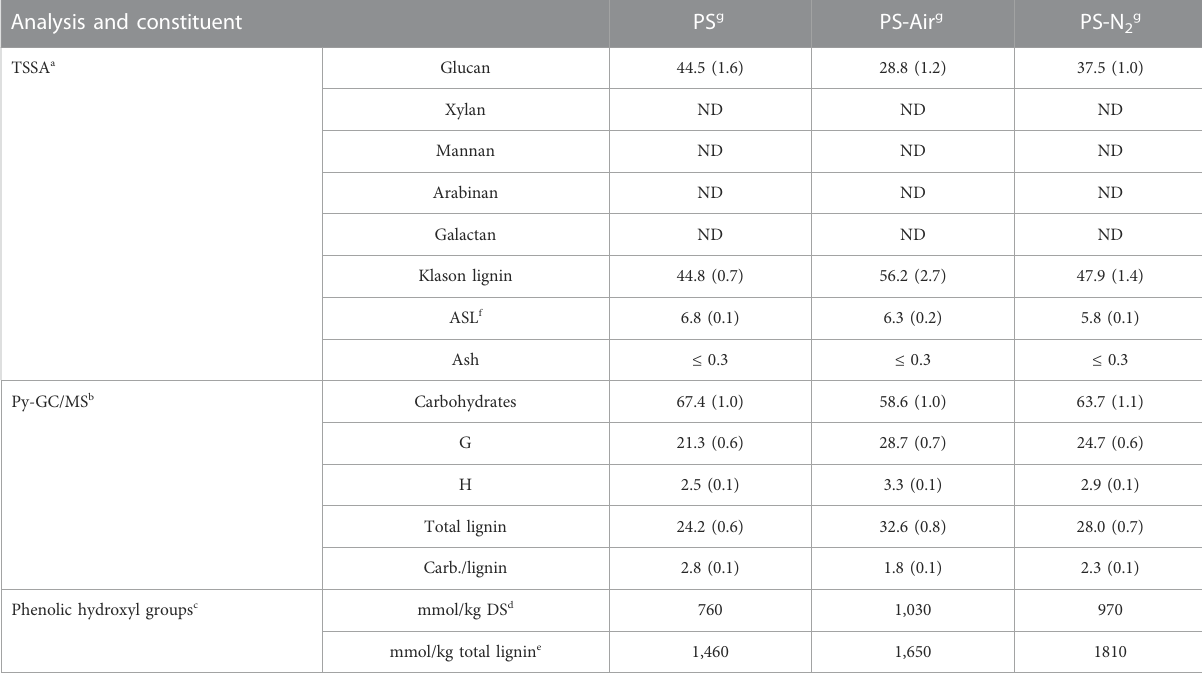
TABLE 1 Analysis of the solid phase of pretreated Norway spruce. Analysis and